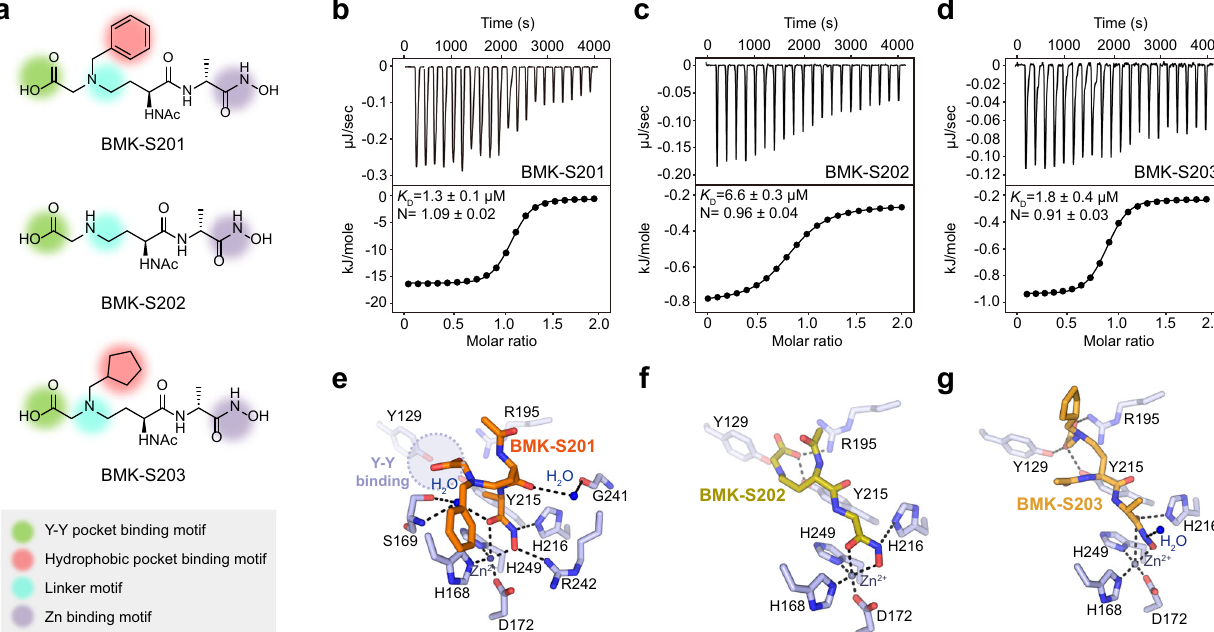
Fig. 3 Structural and functional studies on Pgp3 in complex with BMK-S201 and its derivatives. a Chemical structures of BMK-S201 and its derivatives, BMK-S202 and BMK-S203. Green, red, purple, and cyan circles indicate the Y-Y binding motif, hydrophobic pocket binding motif, Zn binding motif, and linker motif, respectively. b – d The ITC fi tting results of Pgp3 with ( b ) BMK-S201, ( c ) BMK-S202, and ( d ) BMK-S203. The thermodynamic data were collected from titration of each inhibitor into Pgp3, and the parameters were calculated by fi tting to a single-binding model. e – g Detailed interaction of Pgp3 H247A active sites bound with ( e ) BMK-S201 (orange), ( f ) BMK-S202 (olive), and ( g ) BMK-S203 (bright orange). Key interaction residues in Pgp3 are colored with light blue, whereas Zn 2 + ion and water molecules are represented by blue and slate gray spheres, respectively. The coordination of Zn 2 + and hydrogen bonds are represented by black dashed lines. Light blue circle with dashed line represents the Y – Y binding